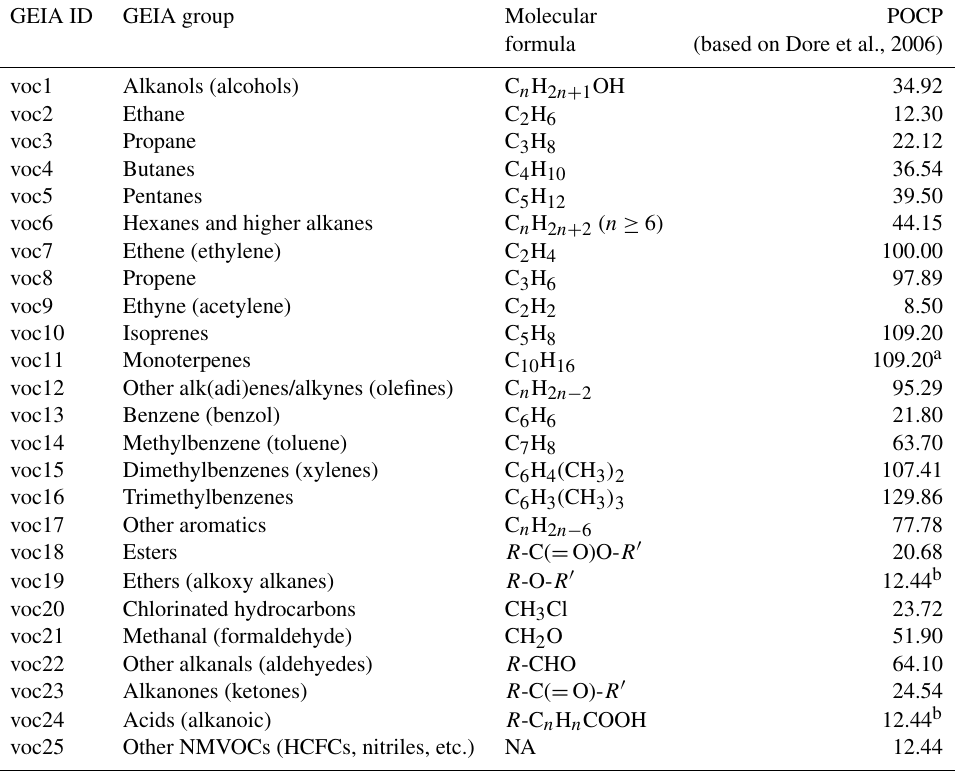
Table 2. List of GEIA 25 NMVOC groups with molecular formulae and Photochemical Ozone Creation Potential (POCP). GEIA ID GEIA